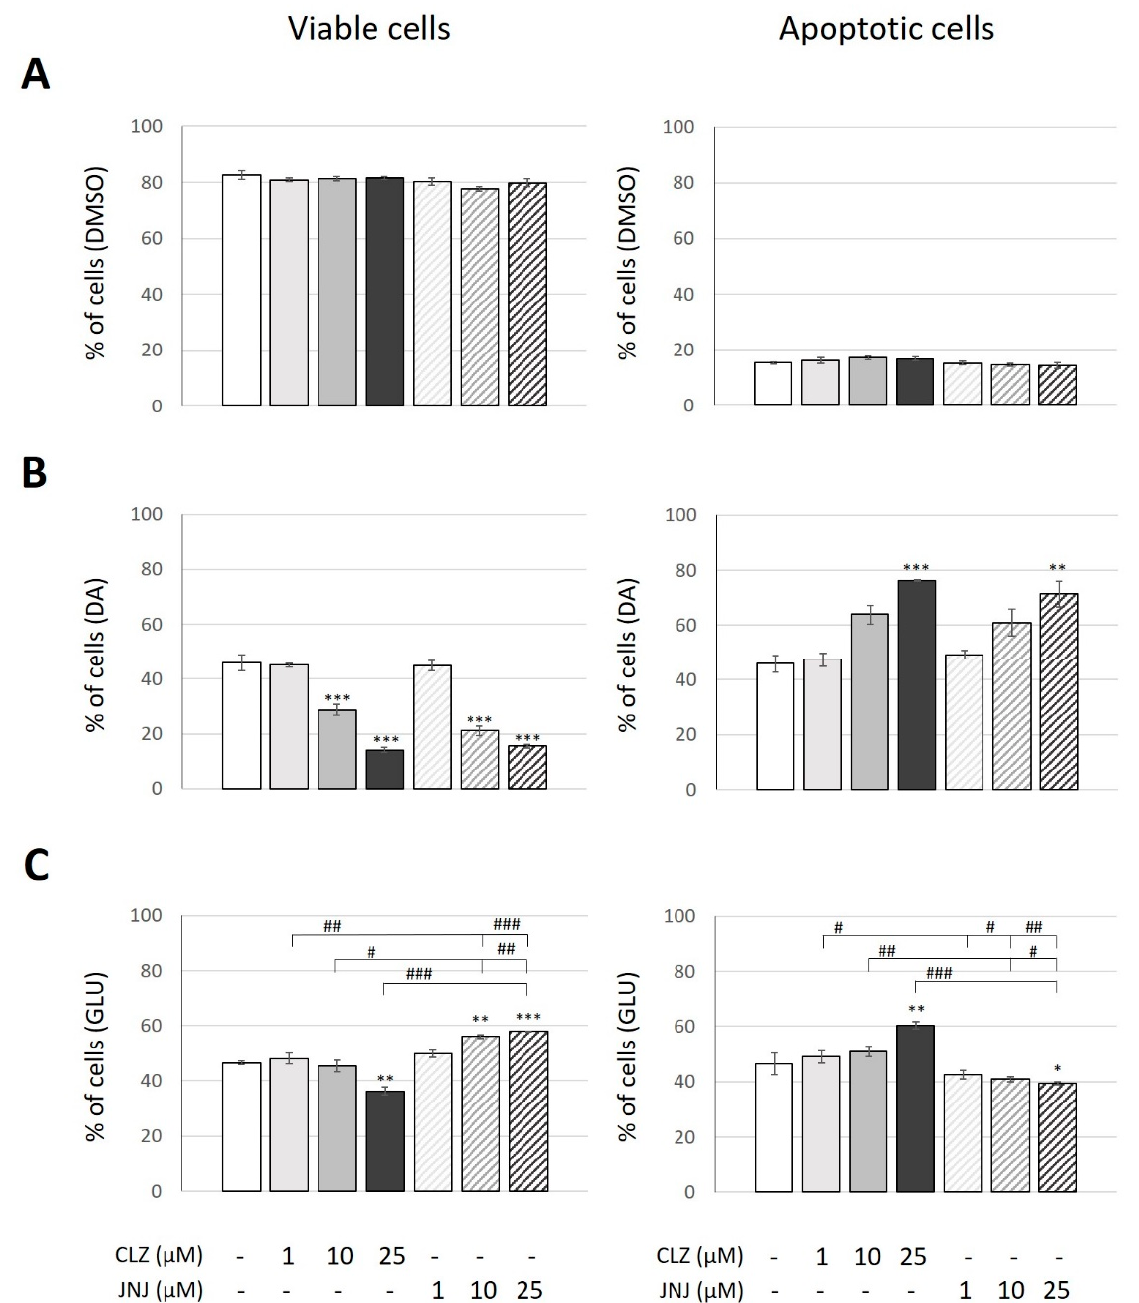
Figure 4. Effects of different concentrations (1, 10 and 25 µM) of clozapine (CLZ) and JNJ-46356479 (JNJ) alone ( A ), in combination with dopamine (DA) at 200 µM ( B ) or in combination with glutamate (GLU) at 160 mM ( C ) on SK-N-SH viability and apoptotic cell death after 24 h as assessed by flow cytometric analysis using annexin-V/propidium iodide (PI). Viable cells were counted as those neg- ative for both annexin-V and PI (annexin-V–/PI–), and apoptotic cells were counted as those positive